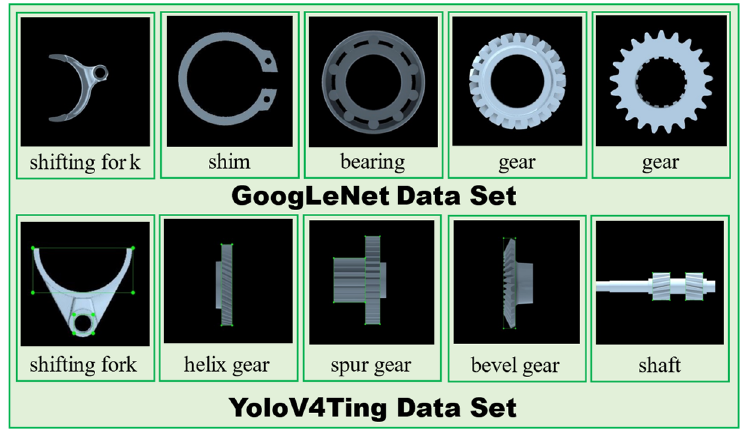
Table 3. Deep learning network training data table .